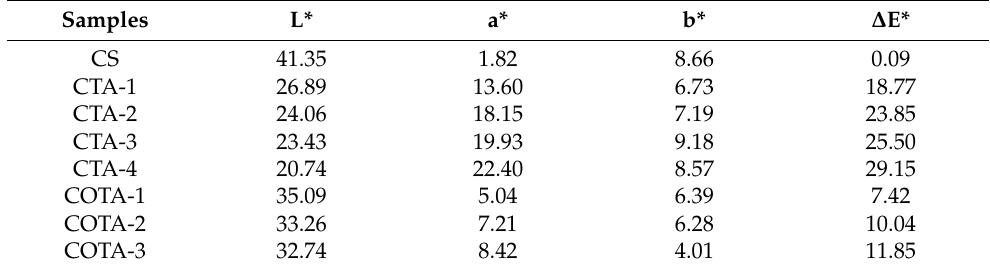
Table 2. Apparent color and light transmittance of CS, CTA, and COTA